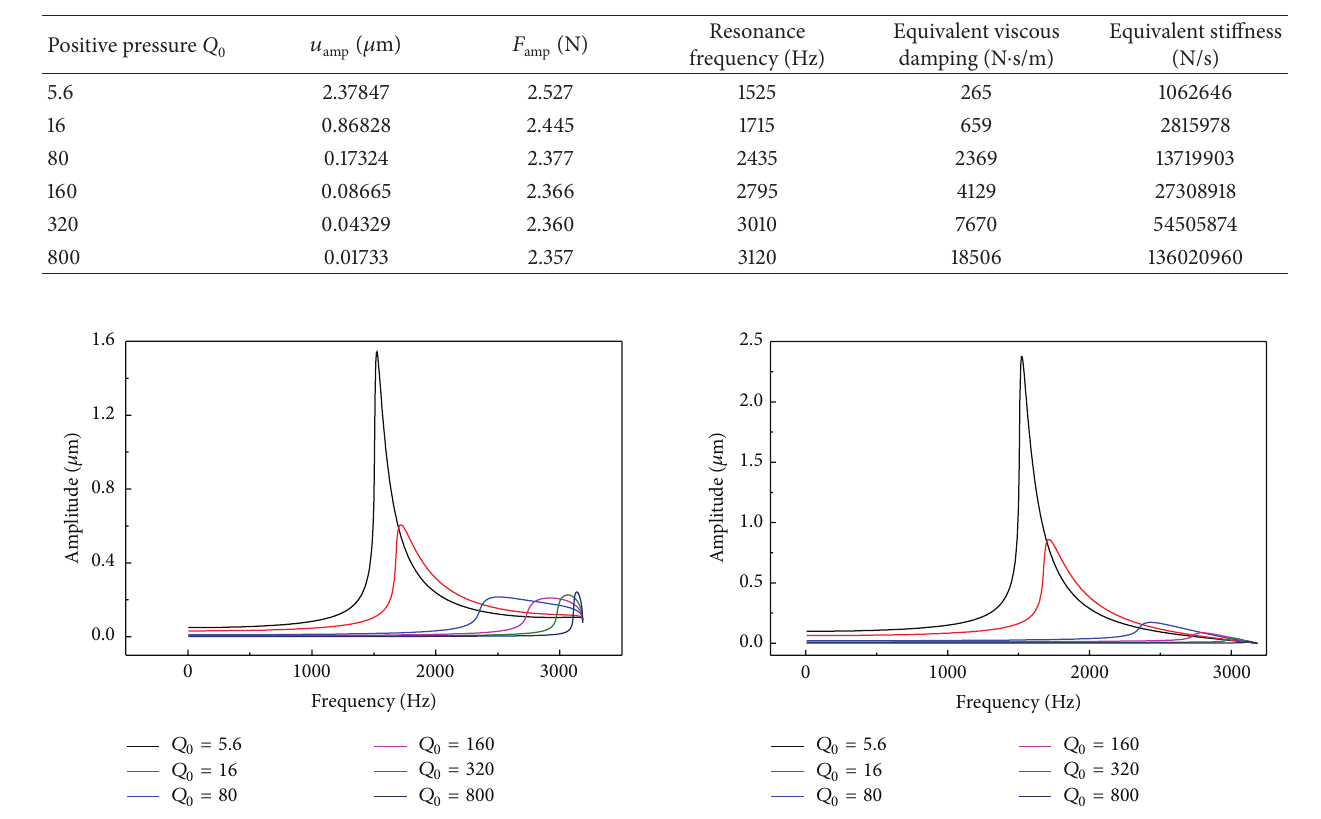
Table 2: Resonance parameters of shroud structure damper.